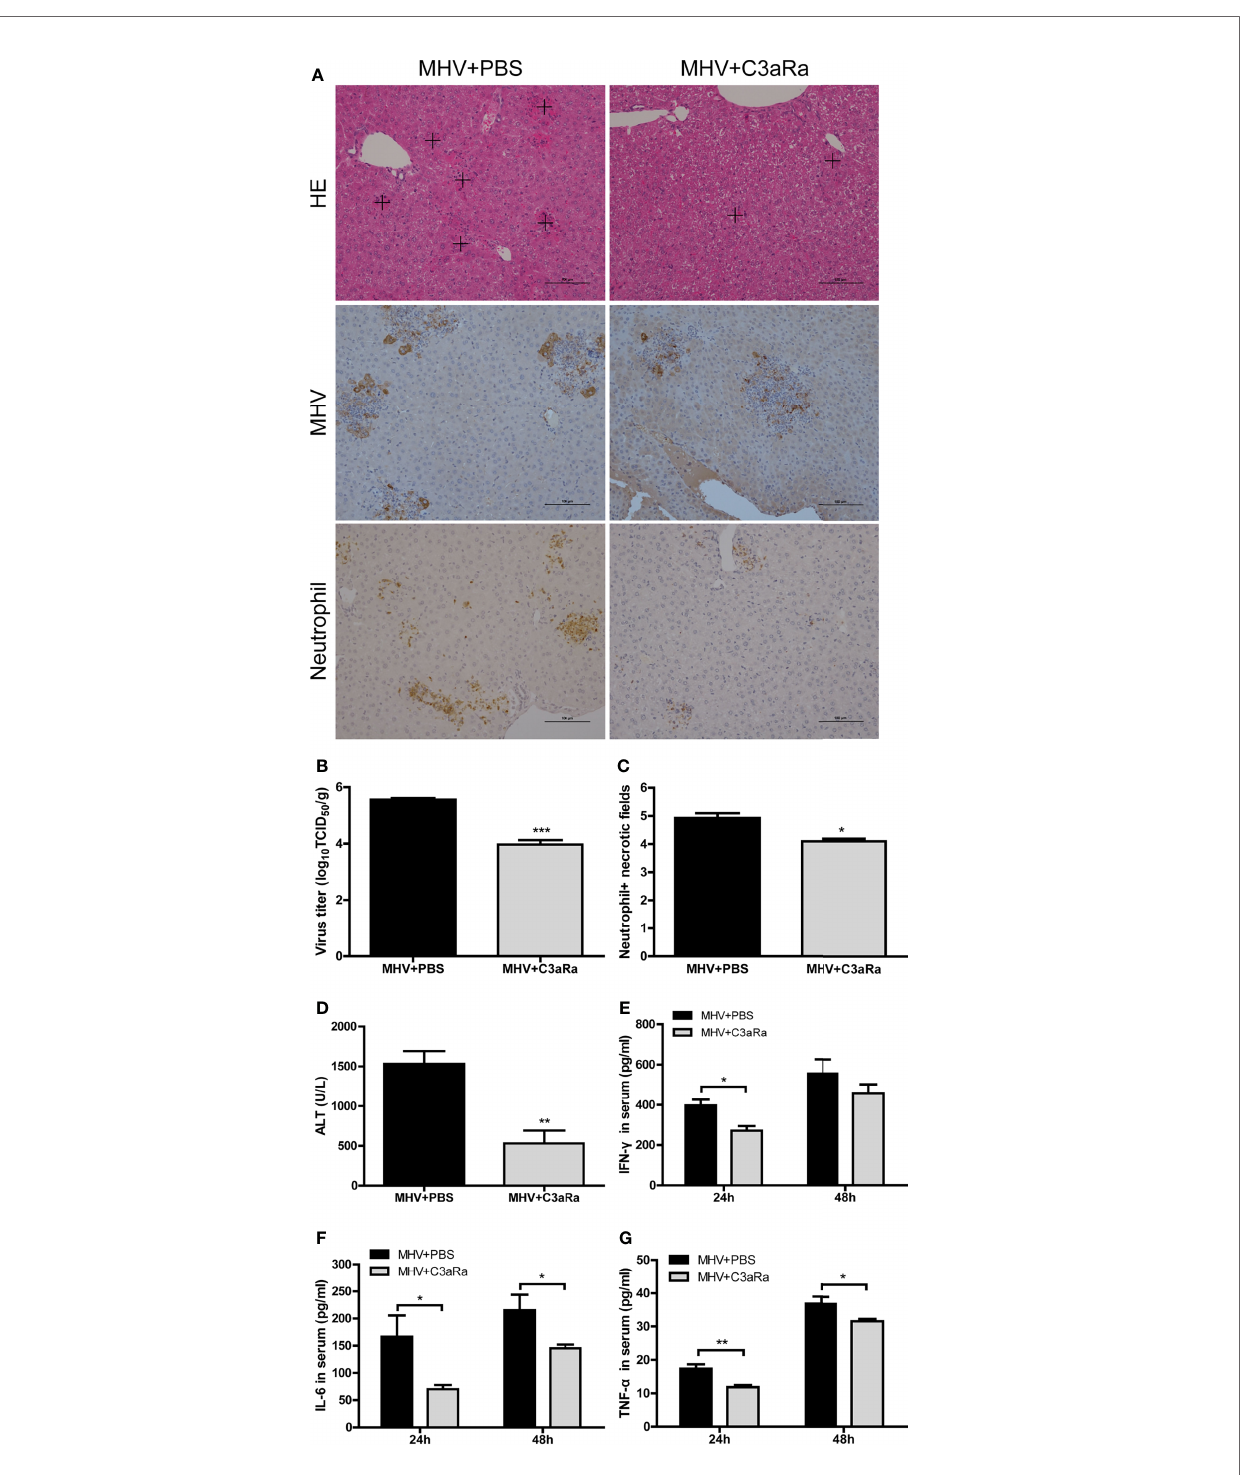
FIGURE 4 | Attenuated liver damage in mice treated with C3aR antagonist after MHV-3 infection. Mice were administered C3aR antagonist 12 and 36 hrs after MHV-3 infection and euthanized, and liver tissue and serum samples were collected. (A) Histological examination of liver tissue, and immunohistochemical staining for viral antigen and neutrophil in fi ltration in mouse livers 48 hrs after virus infection (cross, multifocal damage area). (B) Virus titer in livers 48 hrs after virus infection. (C) Semiquantitative assessment of neutrophil in fi ltration in livers 48 hrs after virus infection. (D) Serum ALT concentrations 48 hrs after virus infection. (E – G) Serum concentrations of proin fl ammatory cytokines 24 and 48 hrs after MHV-3 infection. These results are representative of three independent experiments with similar results (n = 4 – 5 per group). * p <0.05, ** p <0.01, *** p <0.001 compared with WT control. Original magni fi cation, ×